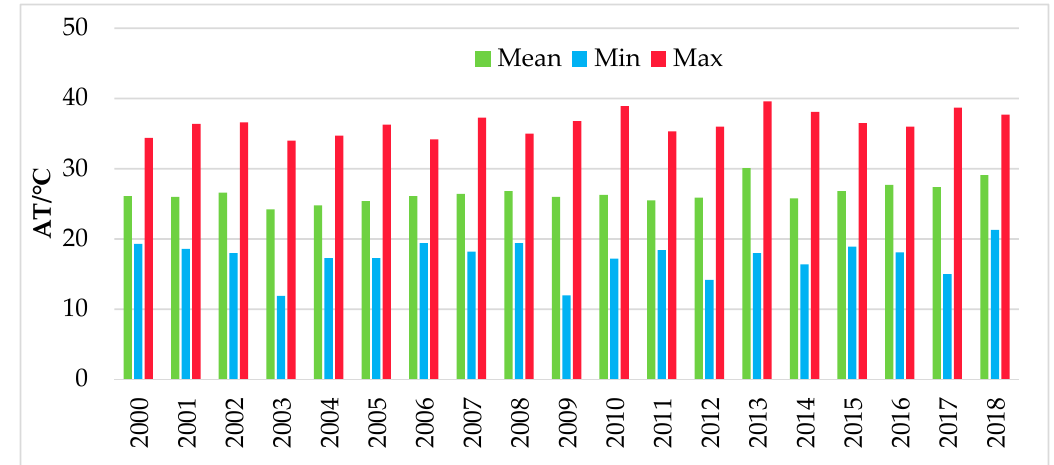
Figure 4. The long term climatic data (Max-Maximum air temperature; Mean-Mean air temperature; Min-Minimal air temperature) of August from the Zhengzhou city Statistical Yearbook (2000–2018).